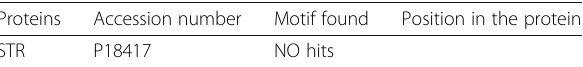
Table 2 Parameters computed using Expasy ’ s Protparam Protein